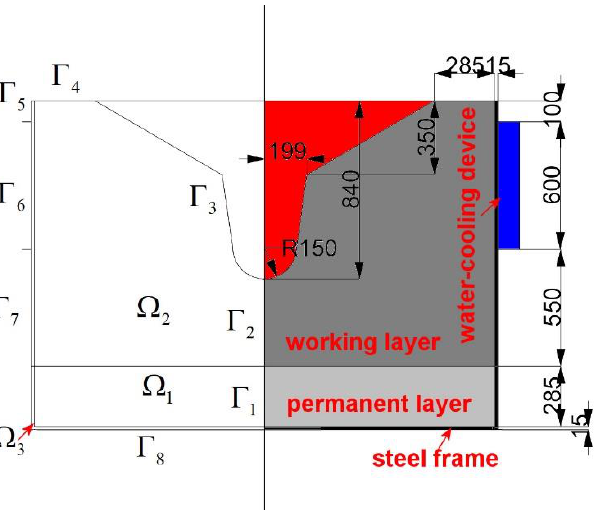
Figure 4. Computation domain and schematic diagram of the cross-section in the trough near the end of a unit campaign cycle (unit: mm).